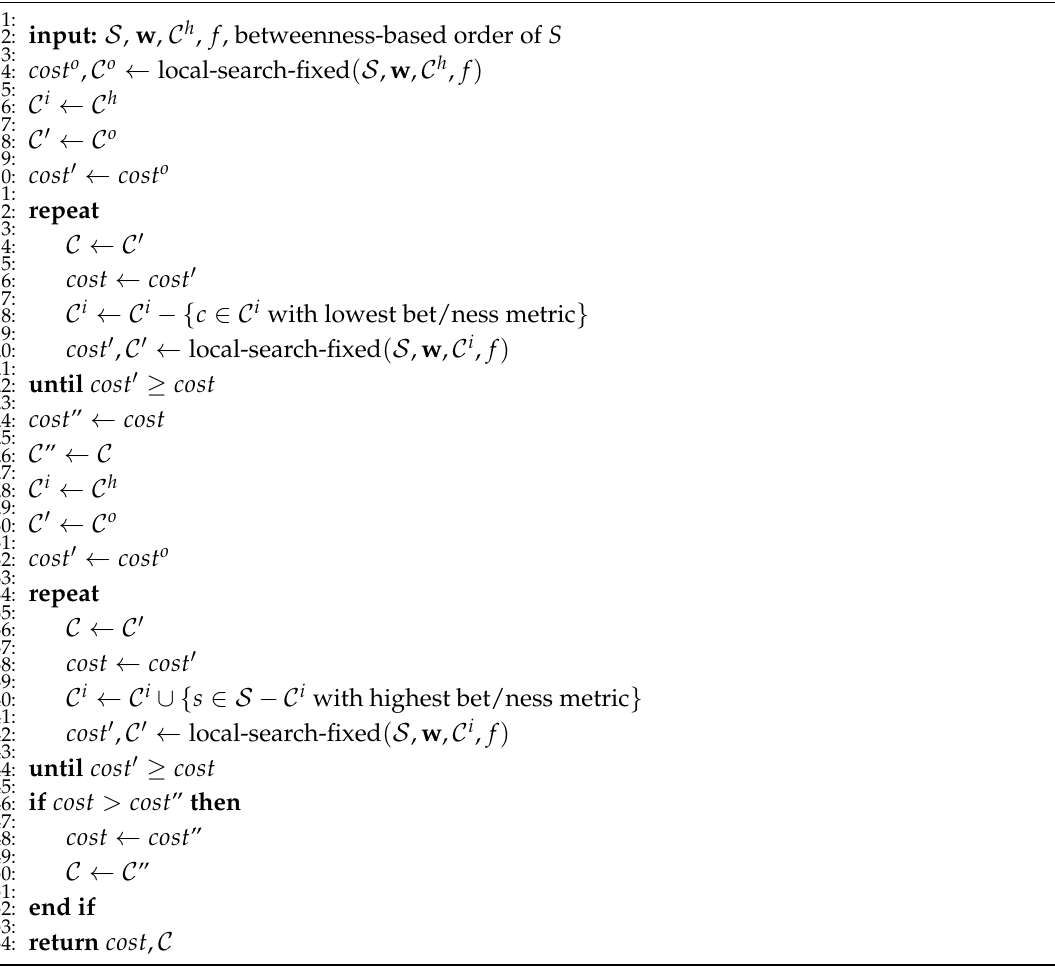
Algorithm 2 Local-search algorithm with variable number of controllers